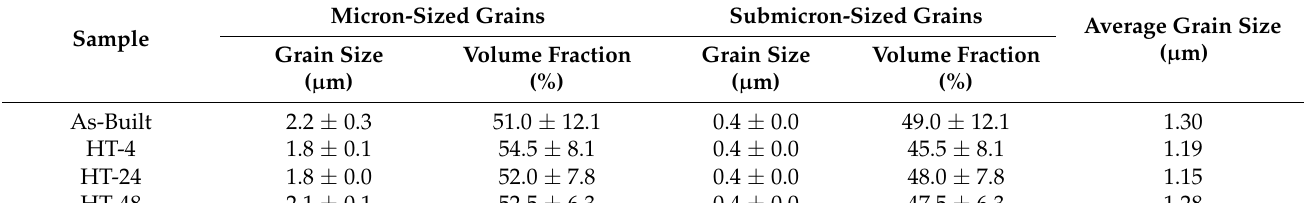
Table 2. The grain size and volume fraction of micron-sized grains and submicron-sized grains of the as-built and heat- treated Scalmalloy samples.